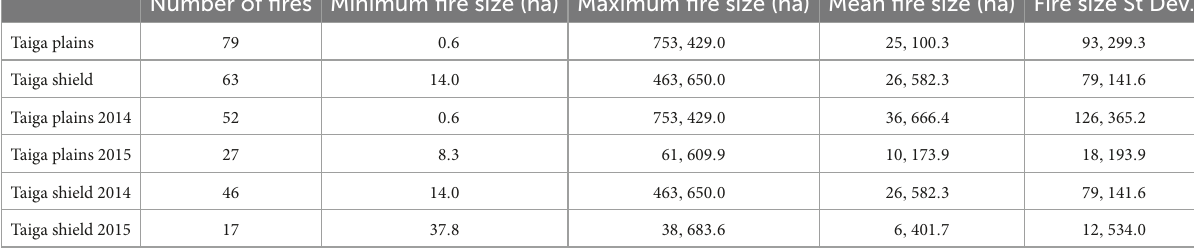
TABLE 1 Number of fires, minimum size, mean, maximum, and standard deviation reported as a cumulative, and by year and ecoregion for the study